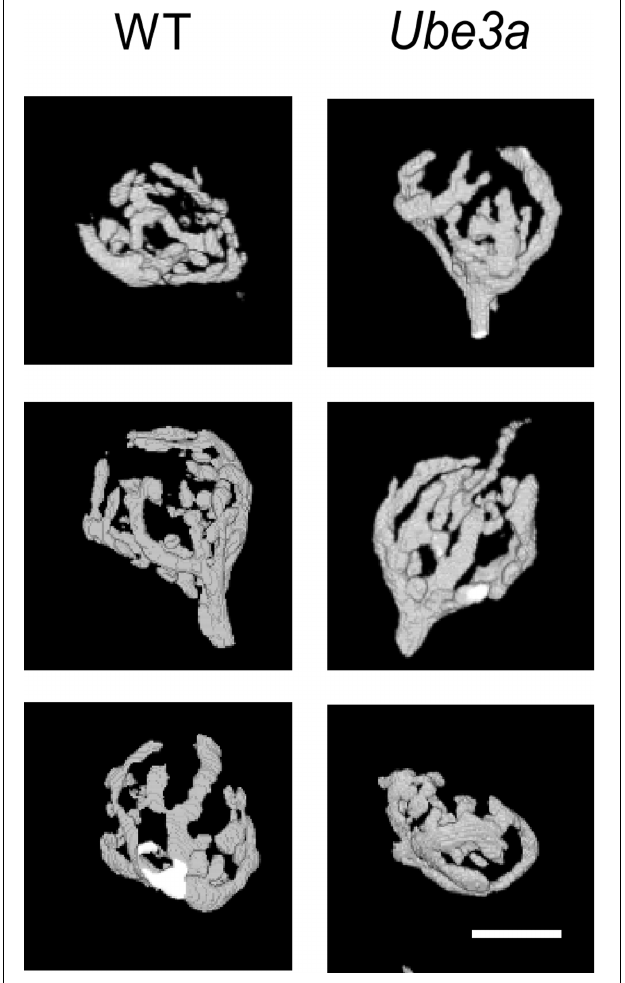
FIGURE 3 | Comparison of morphology of calyx of Held from WT and Ube3a mice. Images of 3D-rendered representative calyces from WT (left column) and Ube3a E113X mice (right column). Scale bar, 10 µ m.